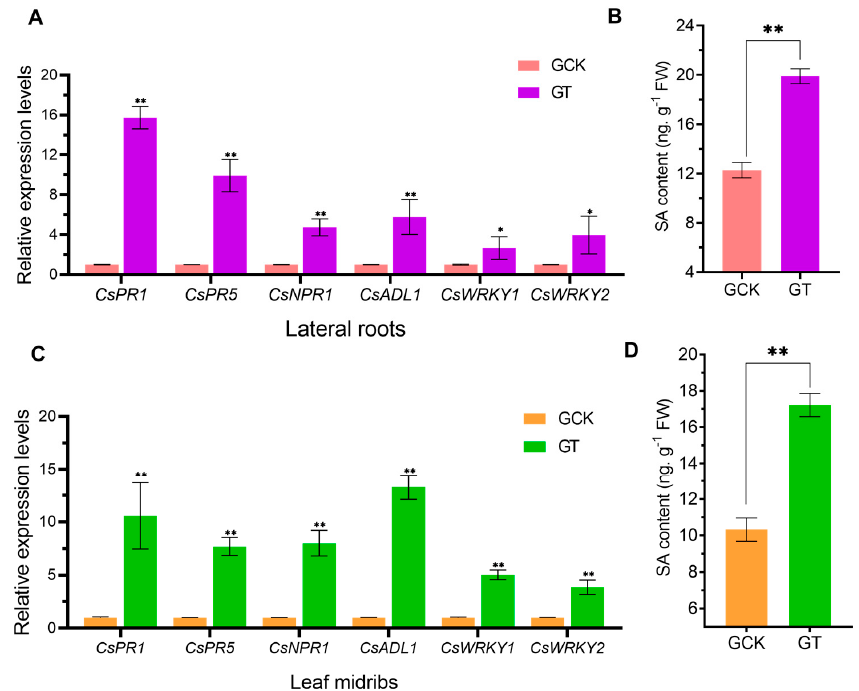
Figure 6. E ff ect of acid soil improvement on transcriptional expression of defence-related genes and SA content in HLB-infected citrus seedlings in the greenhouse trial. Relative expression levels of six plant defence-related genes in lateral roots ( A ) and leaf midribs ( C ) of HLB-infected citrus seedlings in GCK and GT at the fifth month after repotting. Data represent the means (three biologically independent experiments for gene expression) ± SD. Salicylic acid (SA) content determined using high-performance liquid chromatography (HPLC) in roots ( B ) and midribs ( D ) of HLB-infected citrus seedlings in GCK and GT at the fifth month after repotting. Data represent the mean ± SD of three independent biological replicates. GCK, control group in greenhouse trial; GT, treatment group in greenhouse trial; FW, fresh weight. Asterisks indicate a significant di ff erence according to the Student’s t -test: * p < 0.05, ** p < 0.01.